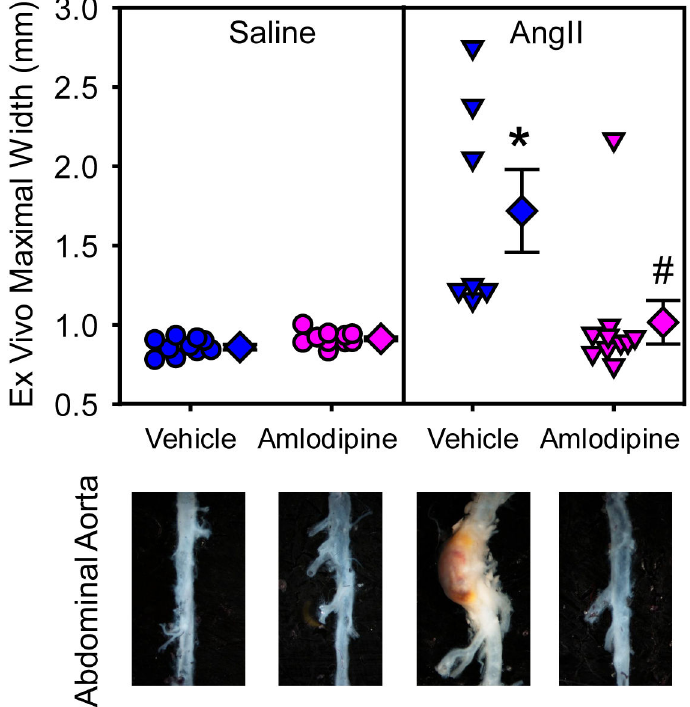
Figure 3. Amlodipine ablated AngII-induced abdominal aortic aneurysms. Ex vivo suprarenal aortic diameter was measured after termination. Circles and triangles are individual measurements, diamonds means of the groups, and error bars SEMs. Representative images of aortas are shown below the graph. Statistical analyses were performed using nonparametric Kruskal- Wallis test. * denotes P=0.0006 for comparison between AngII + vehicle and saline + vehicle, and # denotes P=0.003 for comparison between AngII + amlodipine and AngII + vehicle